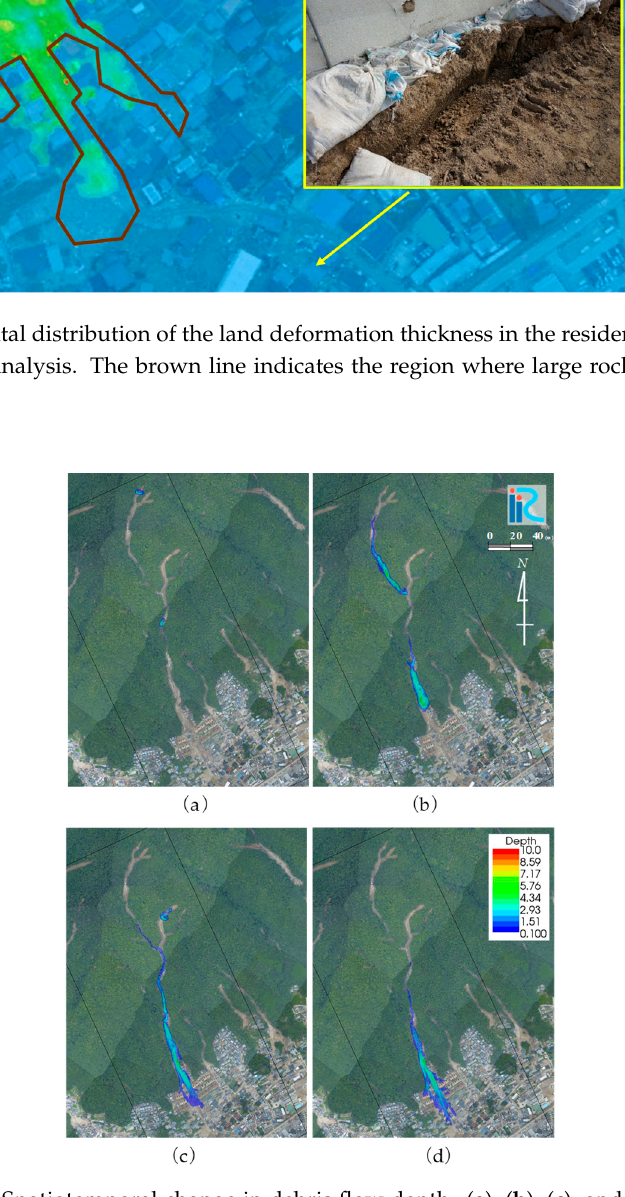
Figure 15. Case 1: Spatiotemporal change in debris flow depth. ( a ), ( b ), ( c ), and ( d ) show the flow depth at 5 s, 43 s, 105 s, and 200 s, respectively.